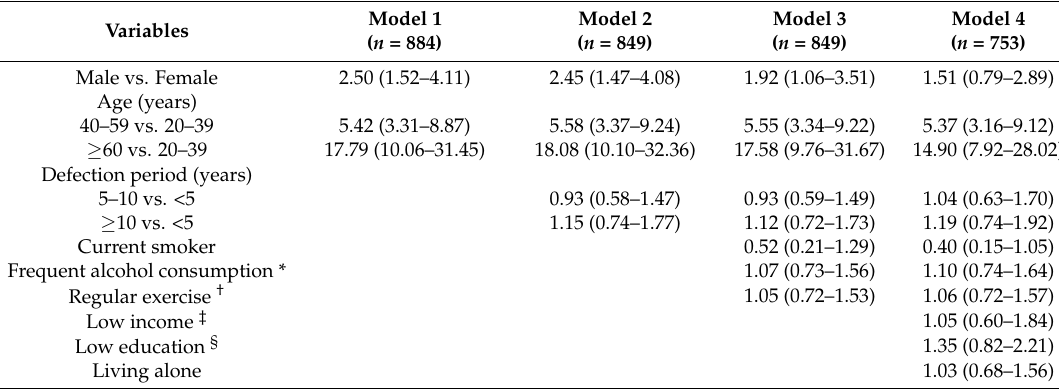
Table 5. Result of logistic regression analyses on central